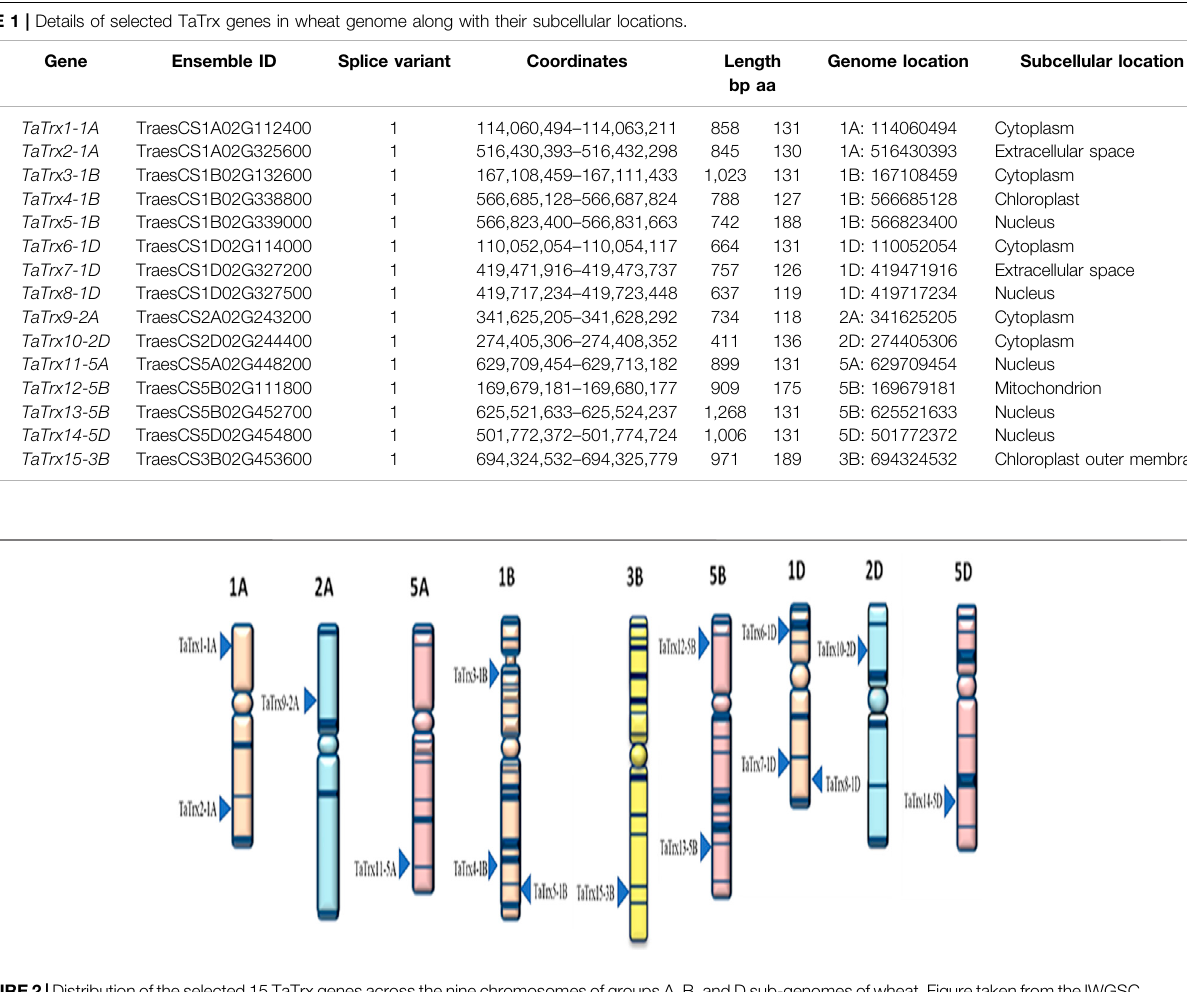
Frontiers in Genetics |